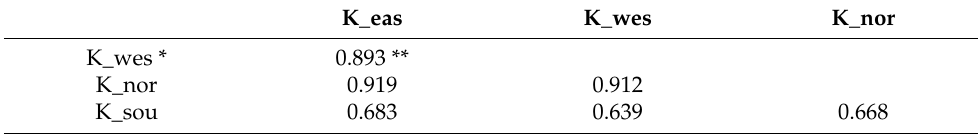
Table 2. Correlation matrix for K in pine #1. K_eas